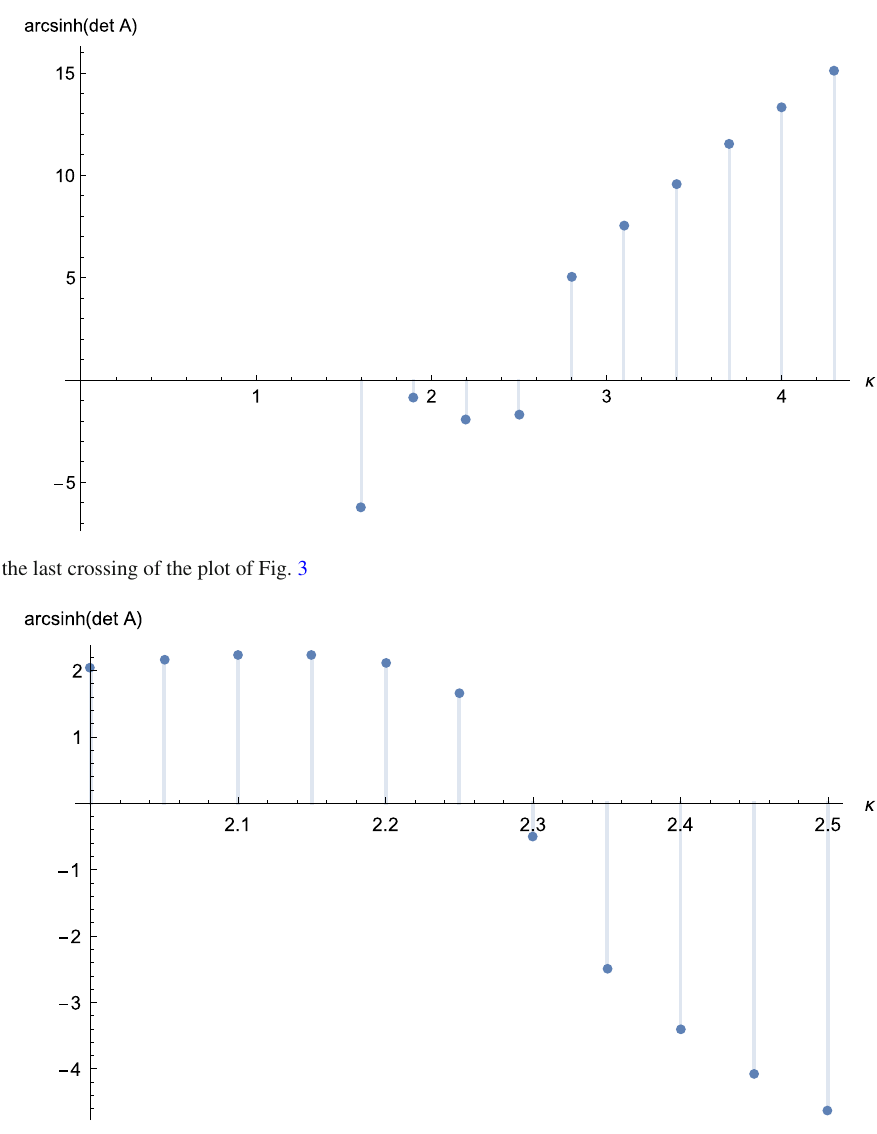
Fig. 5 The behaviour of arcsinh ( det A (κ)) for the 4H γ solution near the last